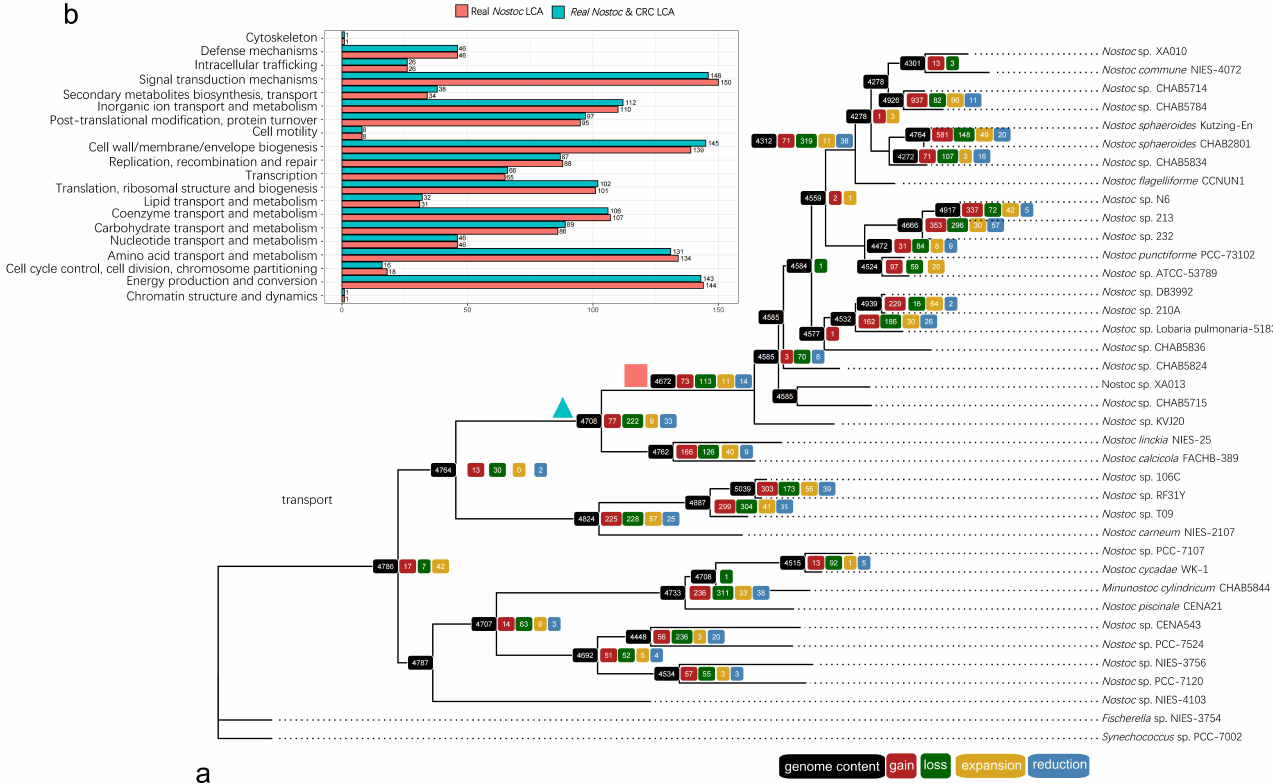
Figure 5. Inferring ancestral genome content by using the Count software. The inference relies on the topology of a single-copy ribosomal protein tree made by Raxml. ( a ) . Gene family numbers involved in evolutionary changes are shown on the tip of each ancestor position. ( b ). Comparison of the genome of the last common ancestor (LCA) of CRC and RNS. The green triangle represents the LCA of both CRC and RNS, and the pink square represents the LCA of